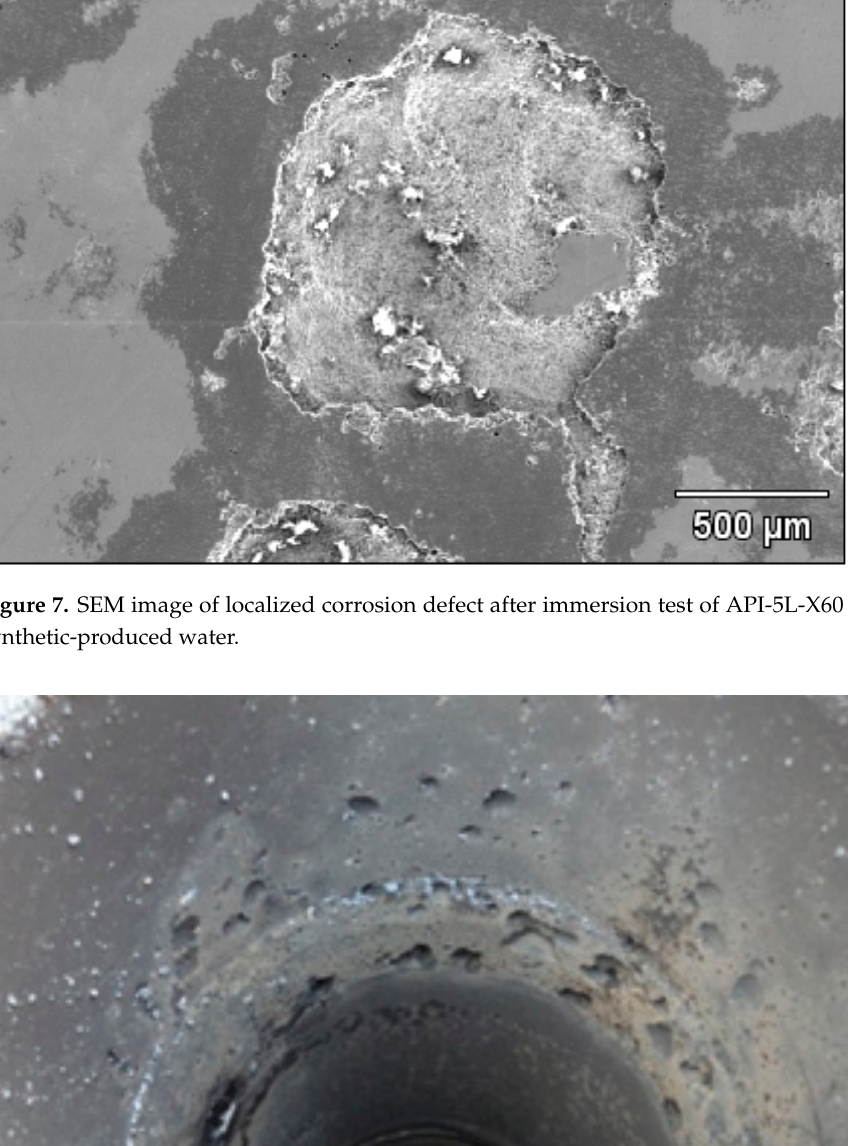
Figure 6. Maximum pit growth evolution as a function of immersion time of pipeline steel in syn- thetic-produced water according to the results obtained by Velázquez et al. reprinted with permis- sion from ref. [46]. Copyright 2022 Elsevier.